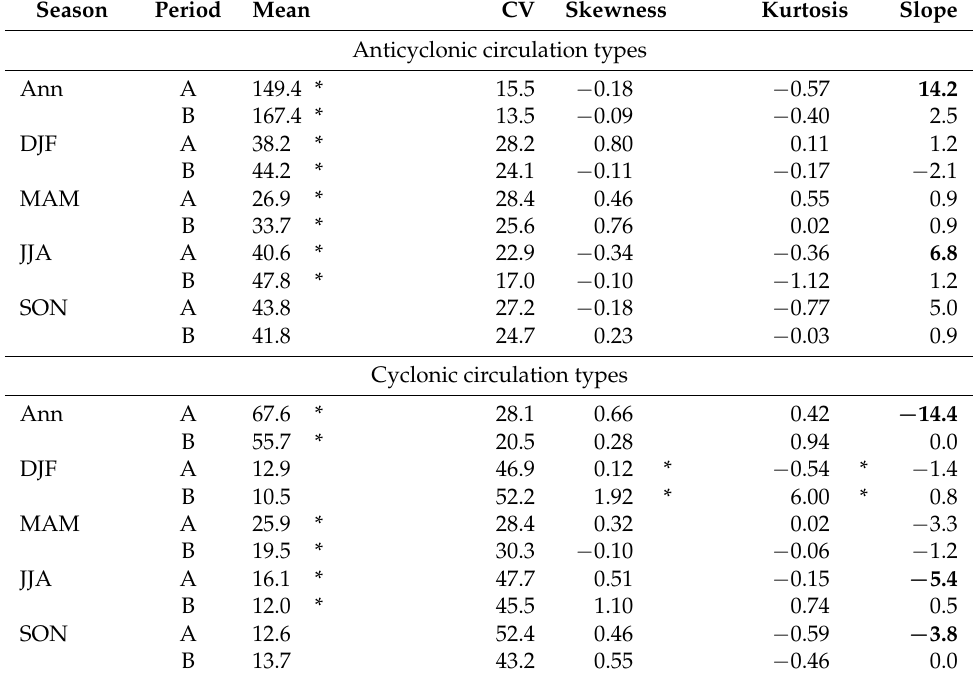
Table 1. Selected statistical characteristics of annual (Ann) and seasonal (DJF, MAM, JJA, and SON) frequencies of days with anticyclonic, cyclonic, and directional circulation types according to the objective classification for the territory of the Czech Republic during the 1961–1990 (A) and 1991–2020 (B) periods: means are in days, variation coefficients (CV) in %, and linear trends in days/10 years (in bold statistically significant at the 0.05 significance level). An asterisk * indicates statistically significant differences of a given characteristic between two 30-year